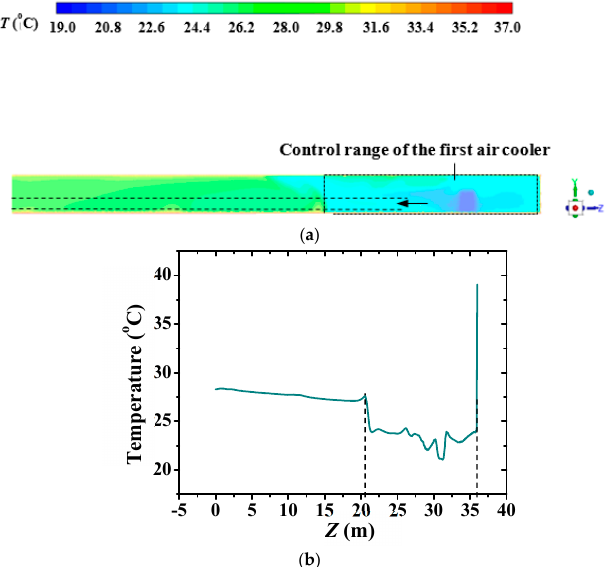
Figure 8. Temperature distribution of airflow in the cooling region for the heading face cooled only by exhaust ventilation.